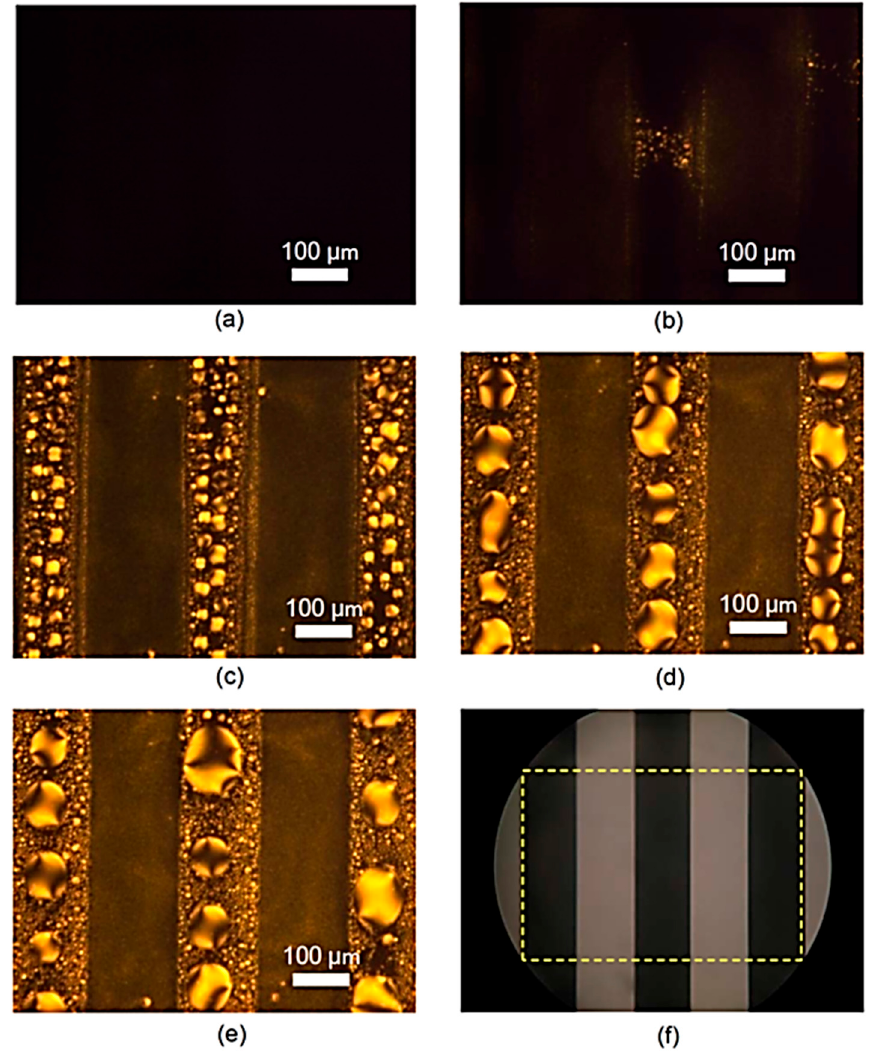
Figure 2. Images of the LC/monomer mixture sample with binary PVK layer at the cooling step from 50 °C to T R in 5 mins at a rate of 5 °C/min observed under the POM with crossed polarizers at cooling time t C = ( a ) 0 s, ( b ) 30 s, ( c ) 60 s, ( d ) 150 s, and ( e ) 300 s. ( f ) The binary photomask pattern observed under the POM (with no analyzer) is displayed for reference to identify the pre-illuminated and non- pre-illuminated regions of the UV light on the PVK layer. The area inside the rectangular dotted frame of this pattern corresponds to the zone of the recorded images shown in ( a – e ).